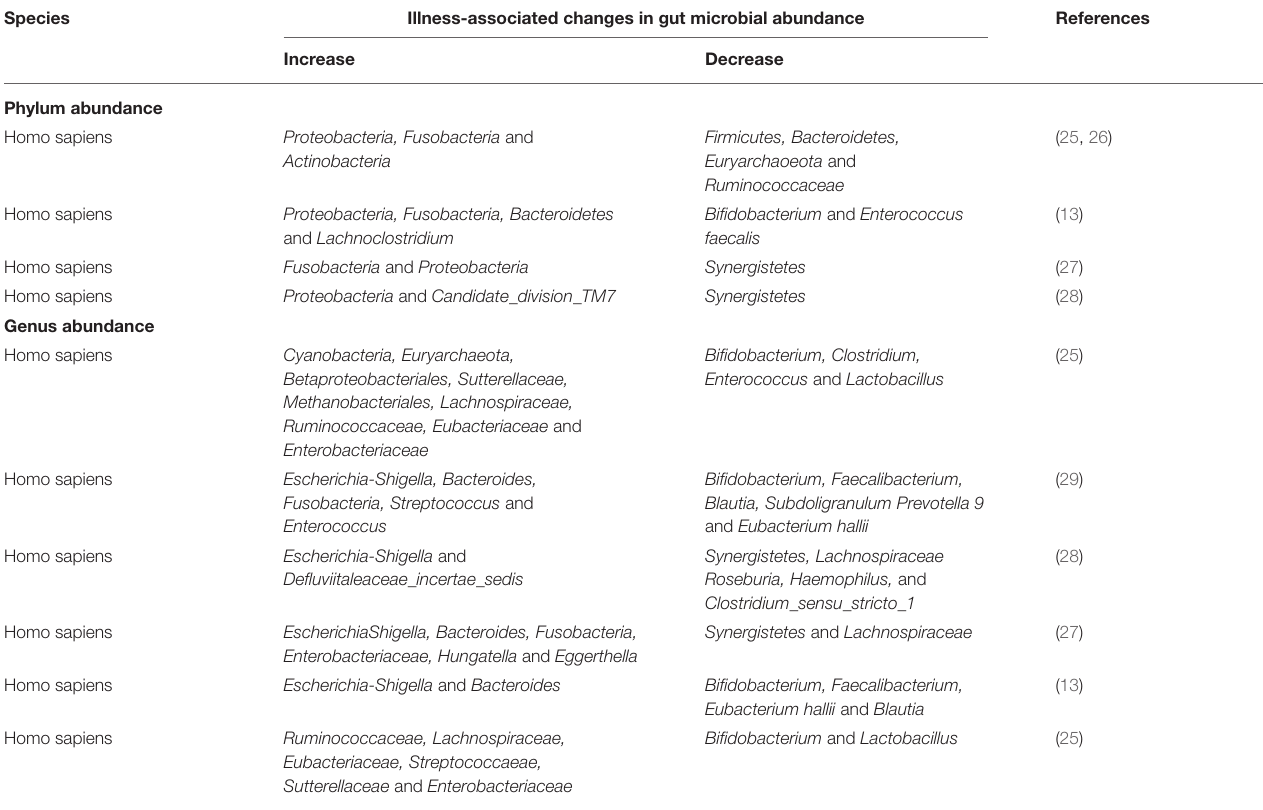
TABLE 1 | Altered gut microbial compositions associated with IgAN-16S